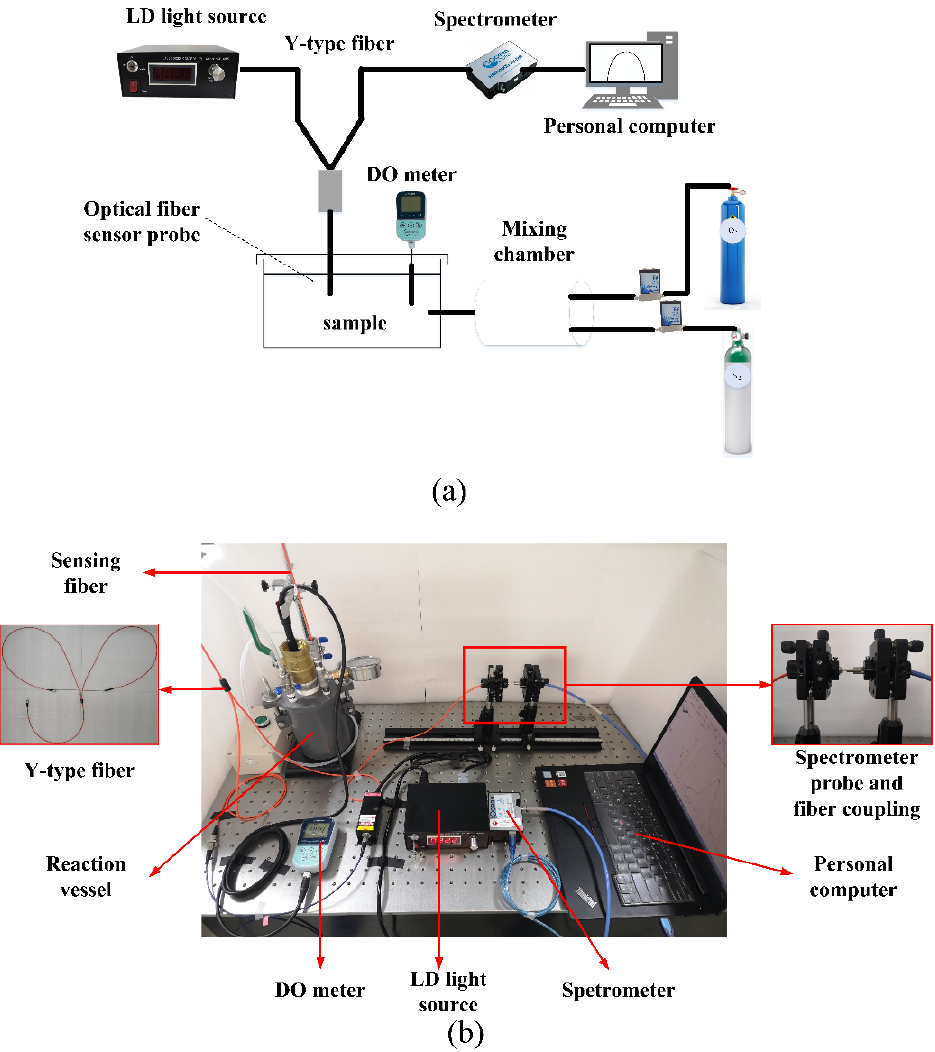
Figure 3. ( a ) Schematic diagram of the experimental setup ( b ) physical picture.